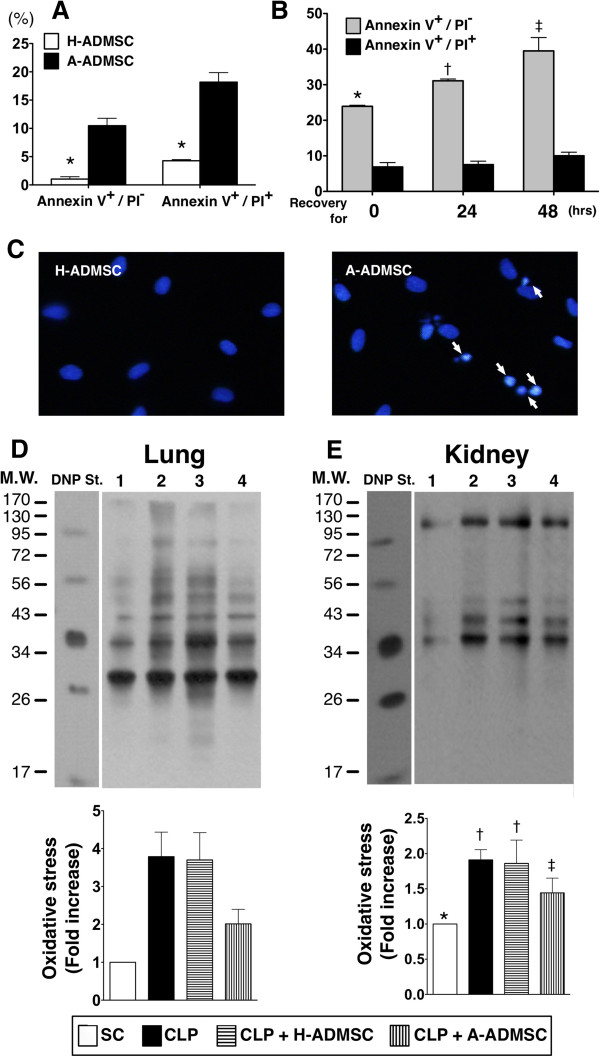
Flow cytometric results of cellular apoptosis and Western blot results of oxidative stress. A) Compares the incidence of early (annexin V+/PI-) and late (annexin V+/PI+) phases of apoptosis between healthy adipose-derived mesenchymal stem cells (H-ADMSC) and apoptotic (A) (that is, 96 hours of serum-free cell culture) ADMSC (A-ADMSC). B) For A-ADMSCs, early apoptosis and late apoptosis increased at 24 hours and further increased by 48 hours after re-culture (after 96 hours of serum-free cell culture) in normal culture medium with adequate nutrition. * versus H-ADMSC in early or late phase of cellular apoptosis, P <0.0001. C) DAPI stain (nuclei were stained in blue color) indicated the cell apoptosis (white arrows). Apoptosis (white arrows) in A-ADMSC was markedly increased at 48 hours after being re-cultured in normal culture medium with adequate nutrition. D and E) Oxidized protein in lung (D) and kidney (E) at 72 hours after cecal ligation and puncture (CLP) procedure. DNP, 1–3 dinitrophenylhydrazone; M.W., molecular weight (Note: The right lane and left lane shown on the upper panel represent control oxidized molecular protein standard and protein molecular weight marker, respectively). 1, sham control (SC); 2, cecal ligation and puncture (CLP); 3, CLP + H-ADMSC; 4, CLP + A-DMSC. * versus other groups with different symbols, P <0.001. Statistical analysis using one-way ANOVA, followed by the Bonferroni multiple comparison post hoc test (n = 8). Symbols (*, †, ‡) indicate significant difference (<0.05). ANOVA, analysis of variance; DAPI, 4',6-diamidino-2-phenylindole.